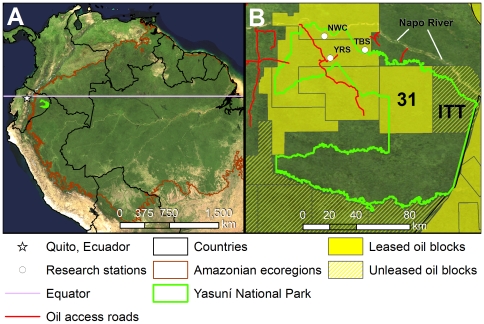
Ecuador's Yasuní National Park.A) Location of Yasuní National Park at the crossroads of the Amazon, Andes, and the Equator. B) Oil blocks and oil access roads within and surrounding the park. ITT = Ishpingo-Tambococha-Tiputini oil fields, NWC = Napo Wildlife Center, TBS = Tiputini Biodiversity Station, YRS = Yasuní Research Station. The image background is the Blue Marble mosaic of MODIS satellite images.